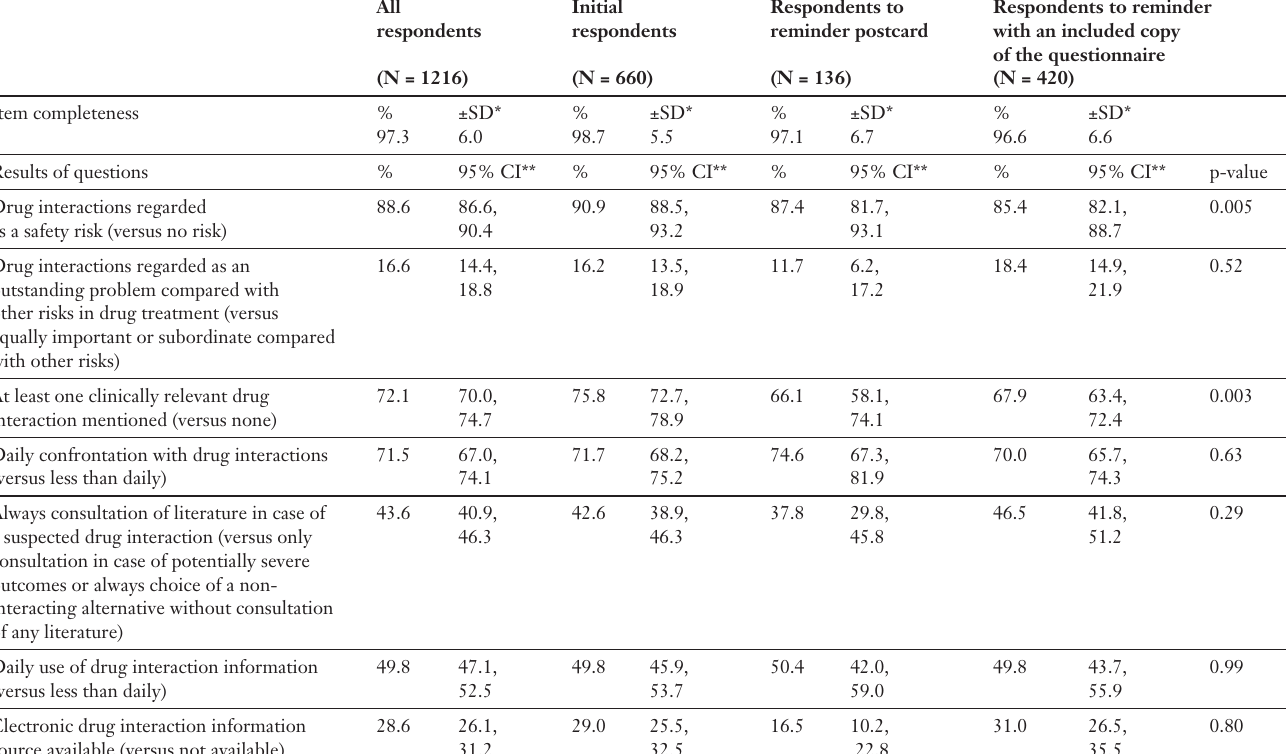
Table 1 Prevalence of answers to seven questions on perception and current management of drug interactions among 1216 responding general practitioners in a mail survey in Germany, May 2003. Percentages calculated for the total number of respondents and separately for initial respondents and respondents to two consecutive